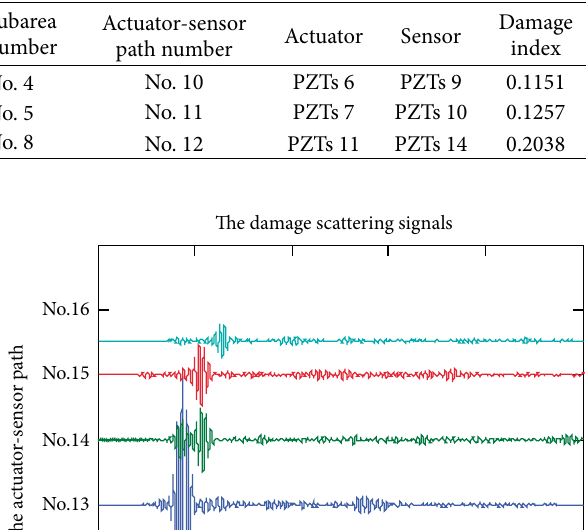
Table 3: The damage indexes of the other diagonal actuator-sensor path of the 3 suspected damage subareas.